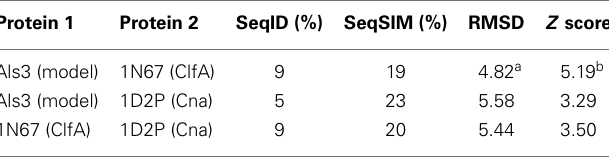
Table 4 | Quantitative sequence and three-dimensional structure homology analysis of C. albicans Als3 and selected homologs from S. aureus (139)